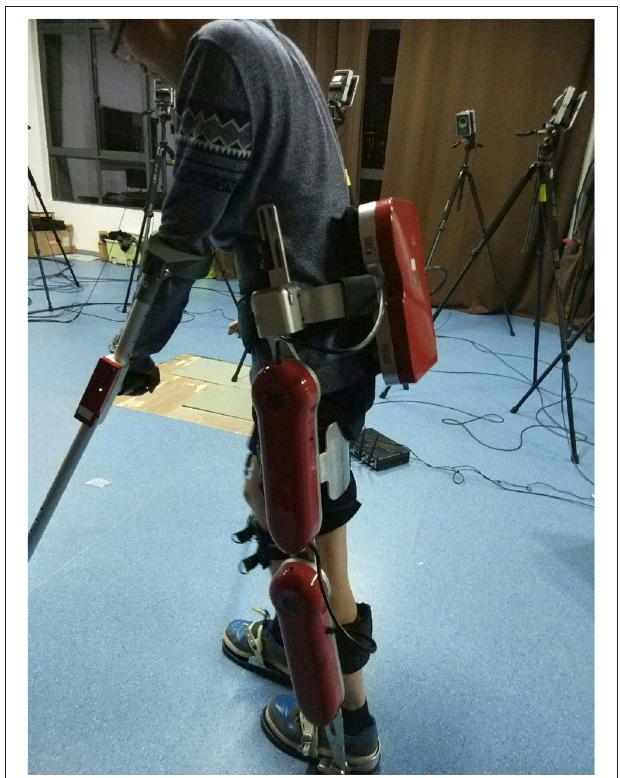
FIGURE 2 | One subject is wearing the lower-limb exoskeleton system and doing a normal walking task. (Consent was obtained from the individual for the publication of this